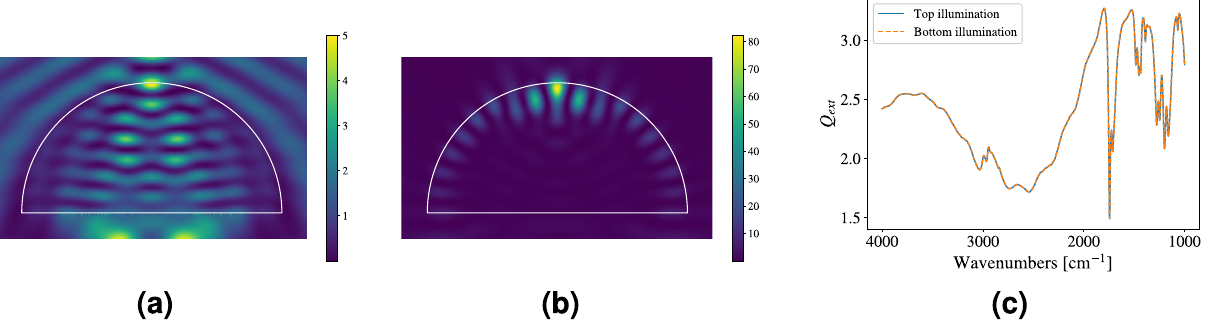
Figure 4. Electric-field distribution | E | 2 inside and outside of a dome with n = 1.5 and R = 10 µ m at 2374 cm − 1 . ( a ) Top illumination. The internal electric-field intensity has the form of horizontal stripes. ( b ) Bottom illumination. The internal electric-field intensity manifests as a whispering-gallery mode. Thus, although Q ext is the same for both illumination directions, the corresponding electric-field distributions inside of the dome are vastly different for top vs. bottom illumination. ( c ) Extinction efficiency for an absorbing dome, with top and bottom illumination. The refractive index of the dome is set to PMMA, as presented in 37 . The extinction efficiency is identical for top and bottom